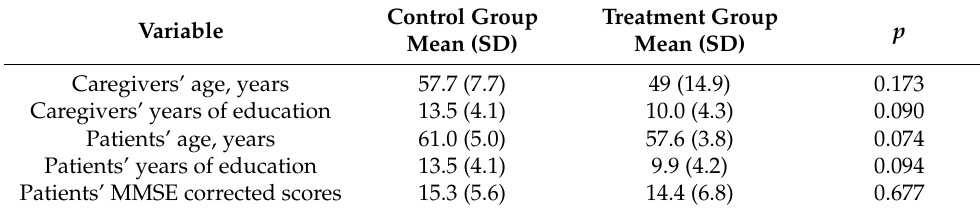
Table 1. Descriptive statistics of caregivers and EOAD